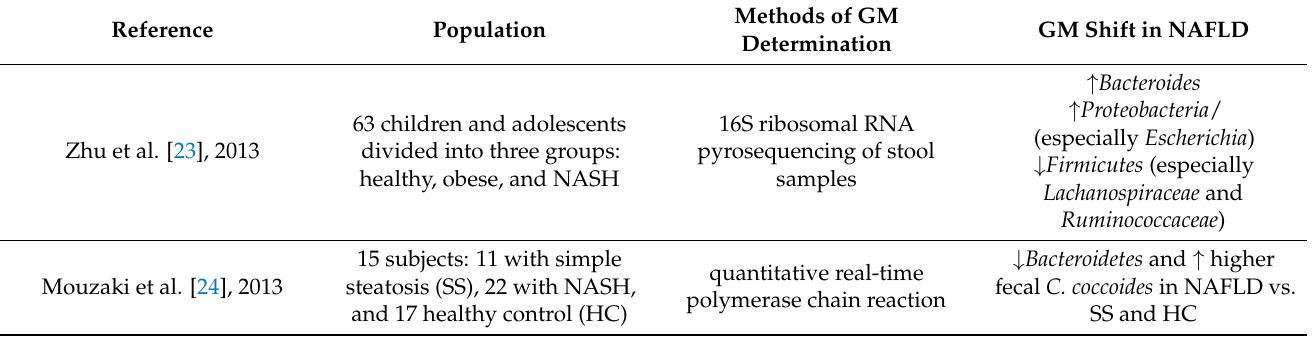
Table 1. The clinical evidence describinggut microbiota (GM) deregulation in non-alcoholic fatty liver disease (NAFLD).